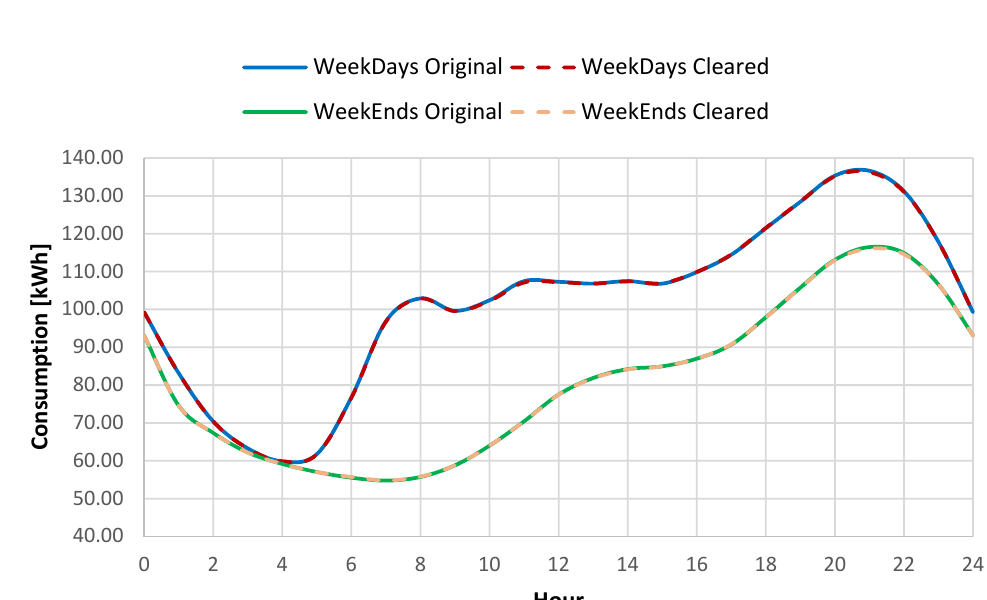
Figure 19. Energy consumption variation range compared to hourly average weekend consumption for original and cleared data sets.